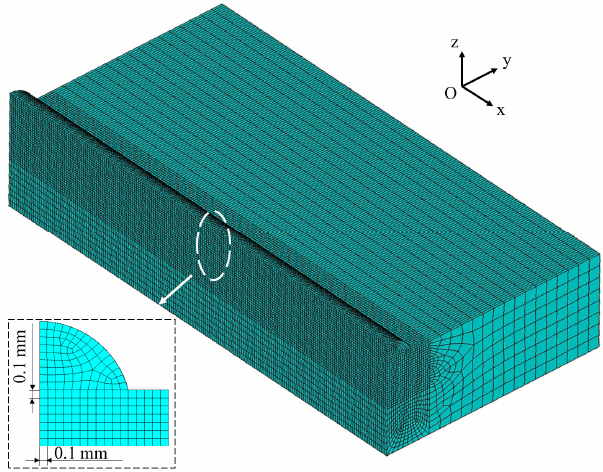
Figure 4. Finite element mesh used in the numerical simulation.